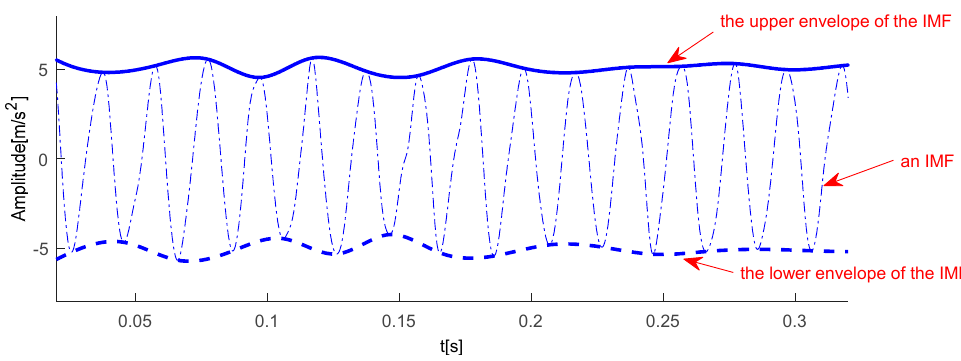
Figure 2. Upper and lower envelopes of an IMF obtained from an axle bearing vibration signal.